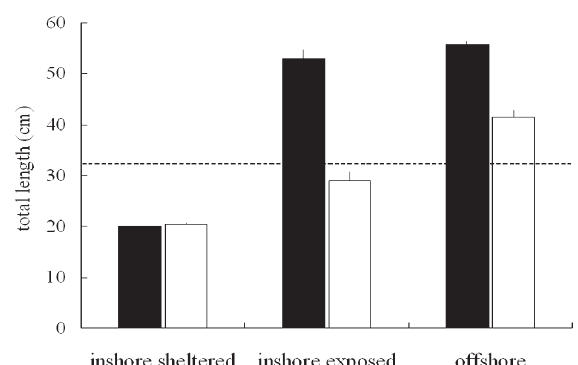
Fig . 7. – total size (x ± se ) of white trevally in transects accord- ing to reef habitat type in corvo (black bars) and faial (white bars). dashed line represents size at first maturity. Table 4. – results of two-way crossed AnoVA of the abundance of mature white trevally in relation to season (spawning vs. non- spawning) and reef habitat type at faial island.